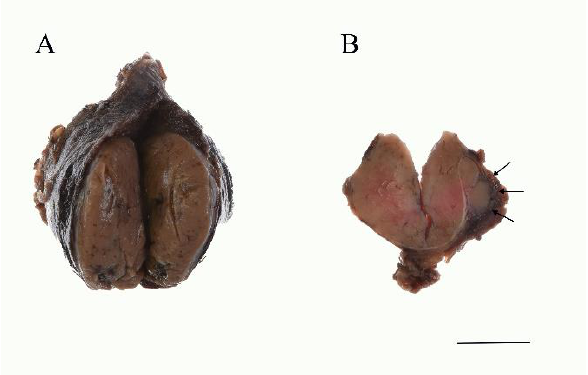
Figure 2. Gross findings of the HCC. ( A ) The tumor is mahogany brown color. Several foci of hemorrhage are noted. ( B ) Widely invasive HCC. Macroscopically, capsular invasion is evident (arrows). Scale bar indicates 2 cm.